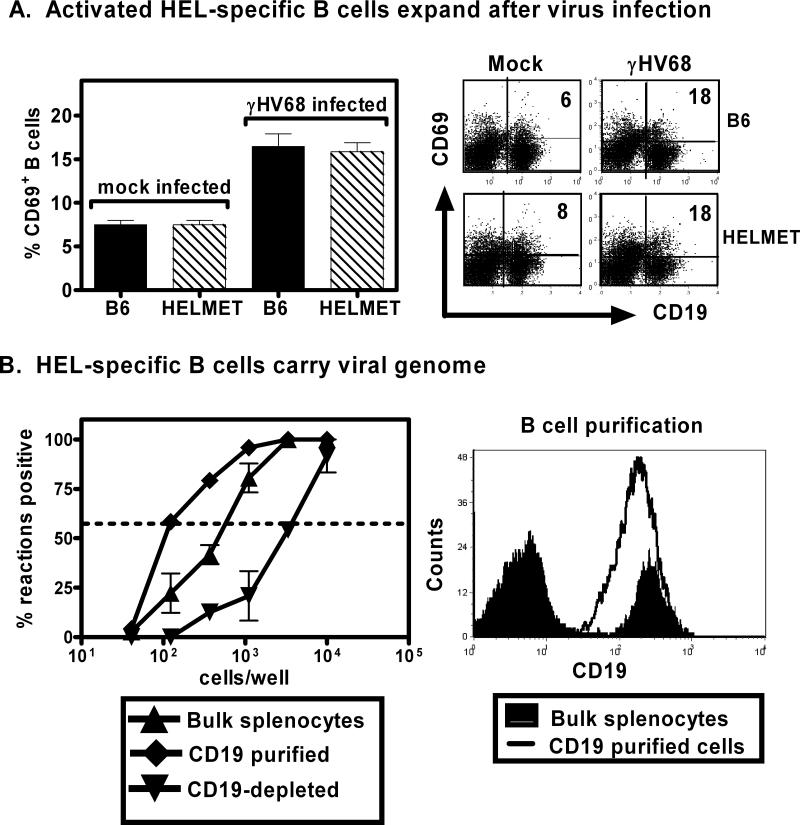
HEL-Specific B Cells Are Activated during γHV68 Infection and Are Infected by γHV68(A) Splenocytes from mock infected and γHV68 infected B6 and HELMET mice were stained with antibodies specific for CD19 and CD69 16 d after infection. Shown are the percentages of splenic CD19+ cells that express CD69 (left). Shown are representative dot plots (right).(B) Frequency splenic HEL-specific B cells that carry viral genome 16 d post infection (left). Shown is a representative histogram of the purity of the B cell population after purification (right). These data are representative of two independent experiments using five mice per experiment.